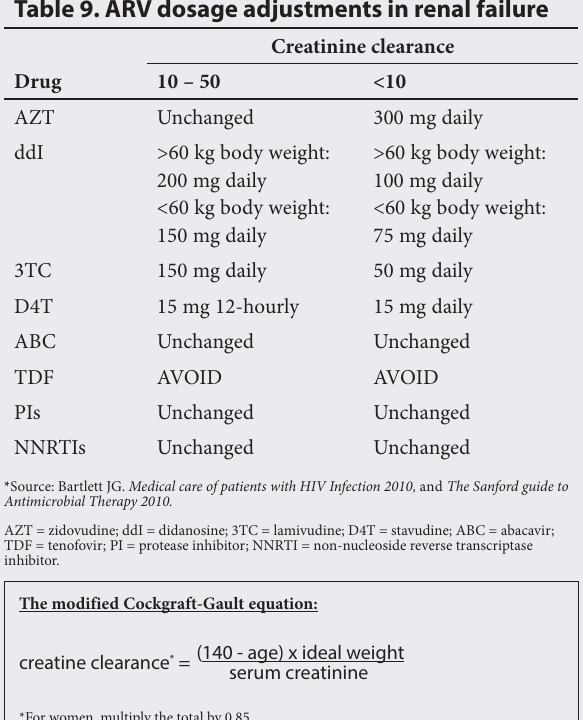
Table 9. ARV dosage adjustments in renal